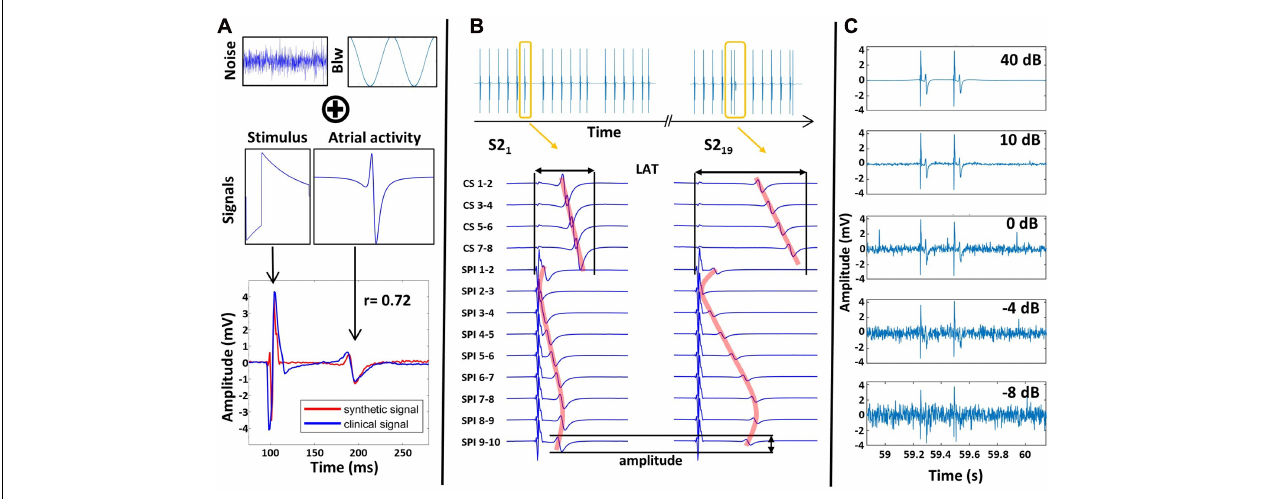
FIGURE 4 | (A) Clinical noise and baseline wander (Blw) are combined with synthetic stimulus and atrial activity signals to create a synthetic signal close to clinical signals with the Pearson correlation coefficient r of 0.72. (B) Complete synthetic S1S2 protocol setup with multiple pacing trains (yellow), catheters, and catheter channels, anisotropic wave propagation (red) as well as amplitude & LAT changes due to restitution. (C) Effect of noise scaling on the